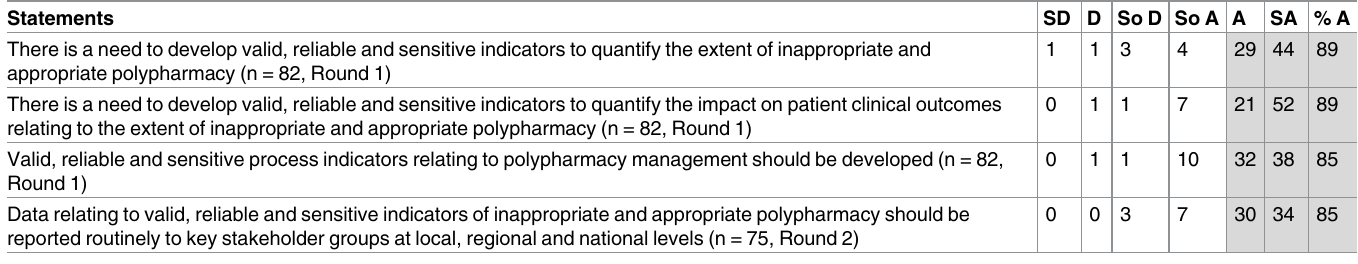
Table 6. Number of responses and % agreement(strongly agree/agree) to statements relating to indicator measures.